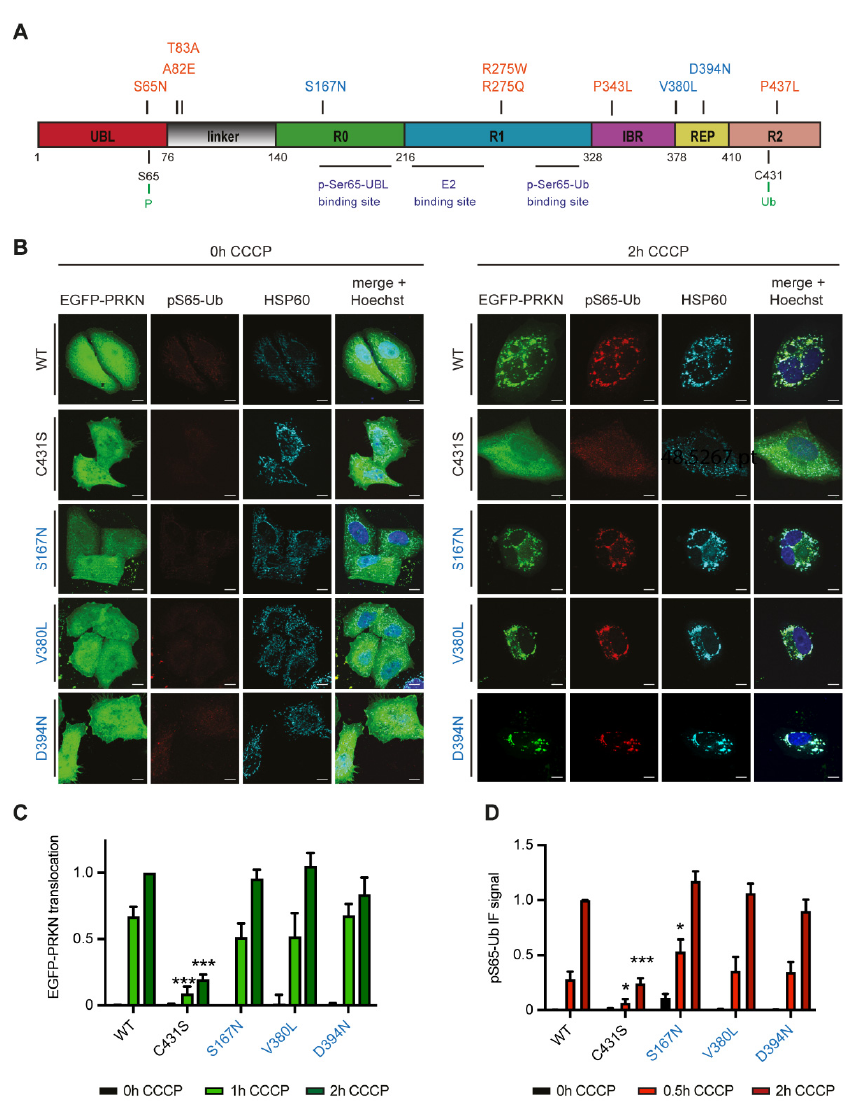
Figure 1. Functional analysis of frequent PRKN variants. ( A ) Organization of PRKN protein with investigated SNVs. Protein domains are drawn to scale and color-coded (red: ubiquitin like domain, grey: linker region, green: RING0/unique PRKN domain, blue: RING1, Purple: in-between-RING domain, yellow: repressor element of PRKN, pink: RING2). Residues Ser65 and Cys431 as well as regions for intramolecular and intermolecular interactions, which are important for PRKN activation and enzymatic function are highlighted below. Rare variants are indicated in orange (<1% MAF), and frequent variants in blue. ( B – D ) HeLa cells were transfected with frequent PRKN variants that were N-terminally EGFP-tagged and either left untreated or treated with CCCP, as indicated. Cells were fixed and stained with antibodies against pS65-Ub and HSP60 as mitochondrial marker and nuclei counterstained with Hoechst 33342. Representative images are shown ( B ). Upon treatment with CCCP, EGFP-PRKN WT but not C431S co-localized with the mitochondrial marker (HSP60, cyan). PRKN co-localization with mitochondria coincided with a visible increase in pS65-Ub at the mitochondria. Scale bars correspond to 10 µ m. Cells were imaged using a HCI microscope and analyzed for PRKN translocation ( C ) or pS65-UB signal intensity ( D ). Data of each experiment was normalized to between 0 h and 2 h for GFP-PRKN WT, set to 0 and 1, respectively. Data is shown as the mean ± SEM of at least six independent experiments with four replicate wells per condition. Statistical analysis was performed using two-way ANOVA and Dunnett’s multiple comparisons test (* p < 0.05, *** p <